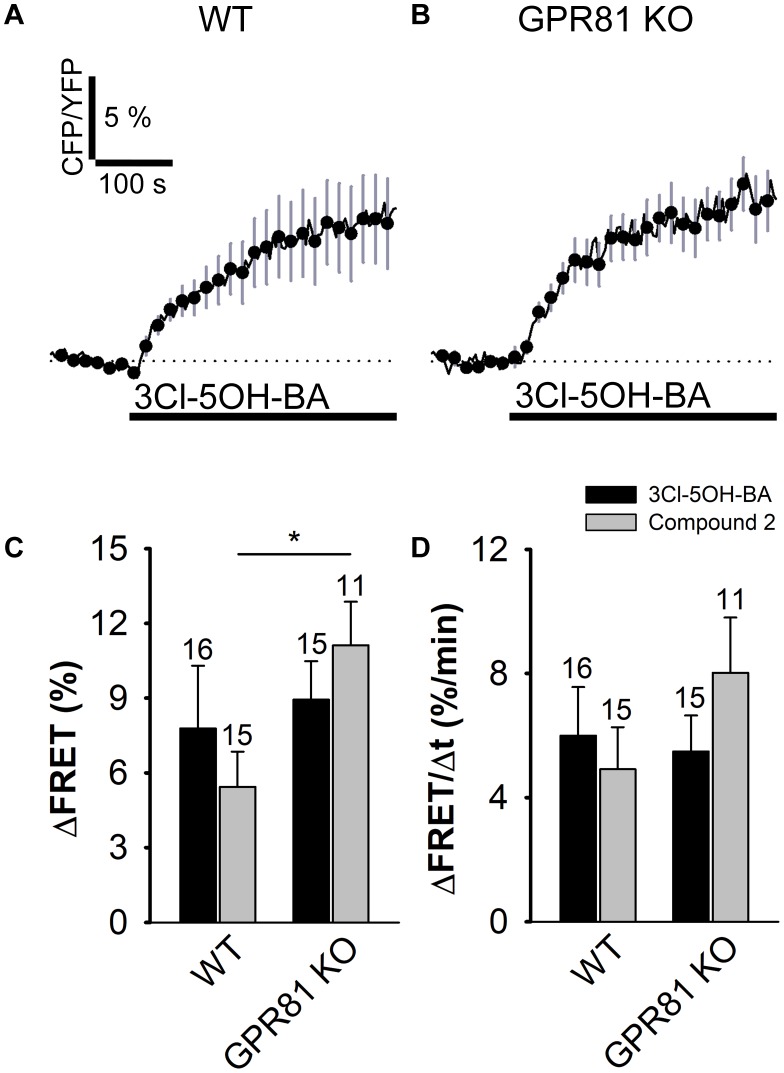
Stimulation with 3Cl-5OH-BA and Compound 2 elicits persistent increase in [cAMP]i in WT and GPR81 KO mice astrocytes expressing the FRET nanosensor Epac1-camps. (A,B) Mean normalized time-courses of the Epac1-camps FRET ratio signal after stimulation with 3Cl-5OH-BA (0.5 mM) in (A) WT (n = 16) and (B) GPR81 KO (n = 15) cultured mouse astrocytes at t = 100 s (black lines). Changes in the FRET ratio signal are expressed as percentages of the inverse FRET ratio signal (CFP/YFP) relative to the baseline values. The monophasic exponential increase in the FRET signal (represented by the CFP/YFP ratio) after 3Cl-5OH-BA stimulation reflects an increase in [cAMP]i. Each data point represents mean ± s.e.m. (C,D) Mean changes in the Epac1-camps FRET ratio signal (ΔFRET; C) and initial rates of the FRET ratio signal increase (ΔFRET/Δt; D) after the addition of 3Cl-5OH-BA (black bars) and Compound 2 (gray bars) in WT and GPR81 KO astrocytes. Numbers by the error bars depict the number of cells analyzed. (∗P < 0.05; Mann Whitney U test) Data for every set of experiment was acquired from at least two different animals except for Compound 2.